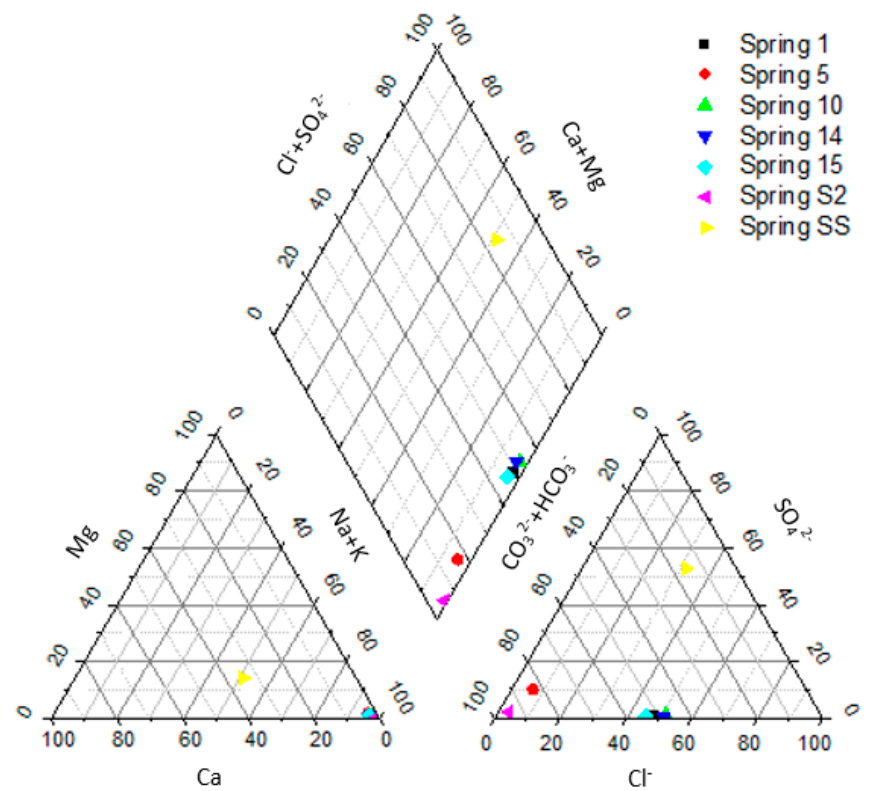
Figure 3. Piper diagram of the studied natural mineral waters.